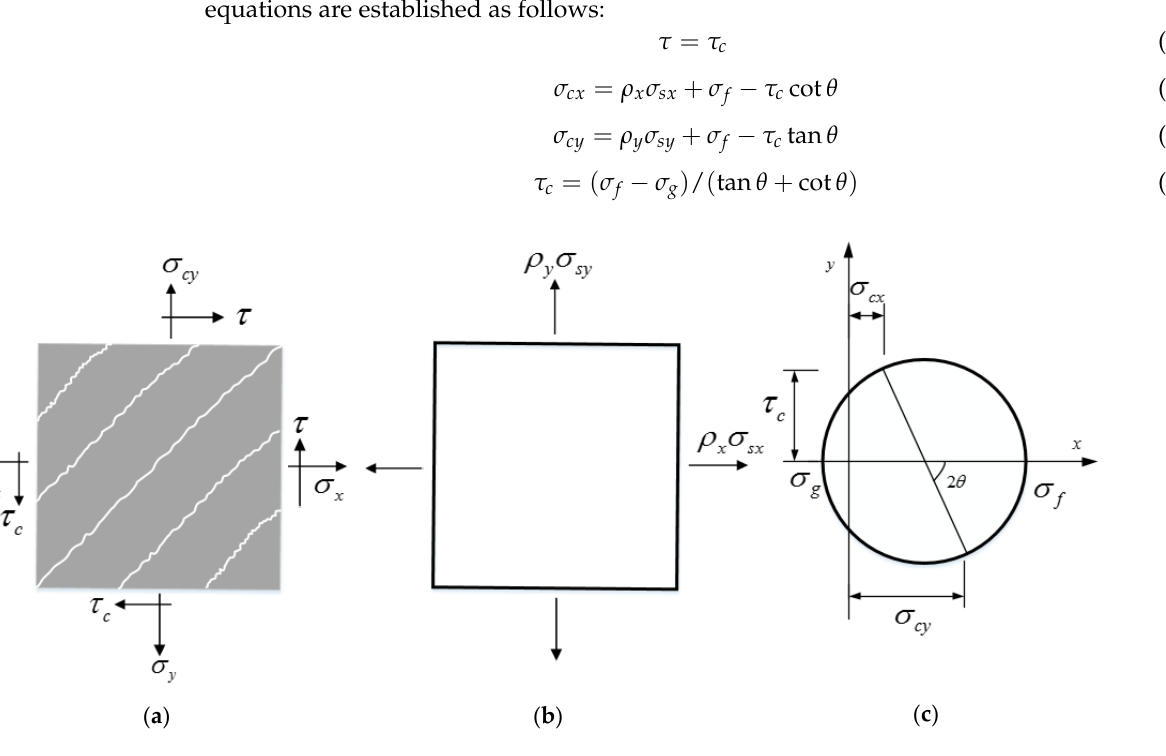
Figure 4. Stress state of RC element and average stress Mohr circle: ( a ) Cracked concrete element; ( b ) Reinforcement element; ( c ) Mohr circle.